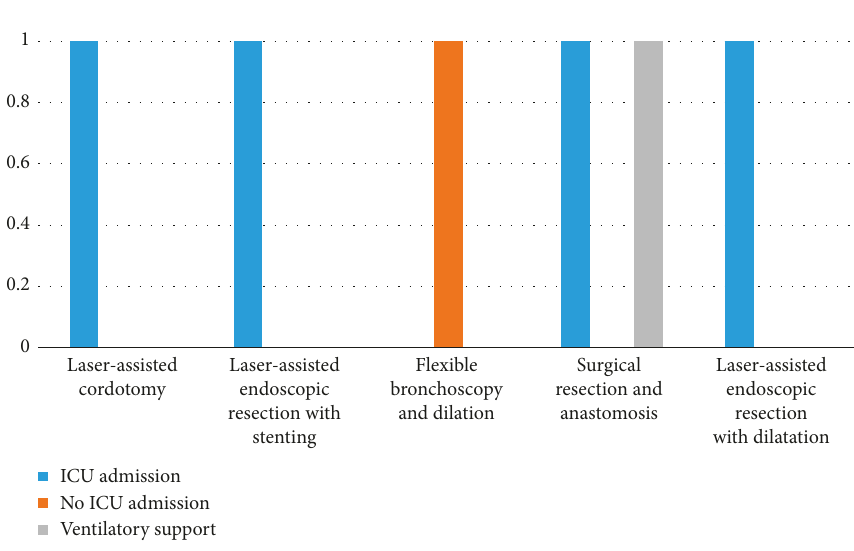
Figure 15: Patients requiring ICU/ventilatory